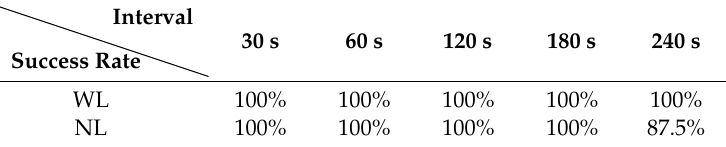
Table 1. Cycle slip fixing success rate in different data gaps.